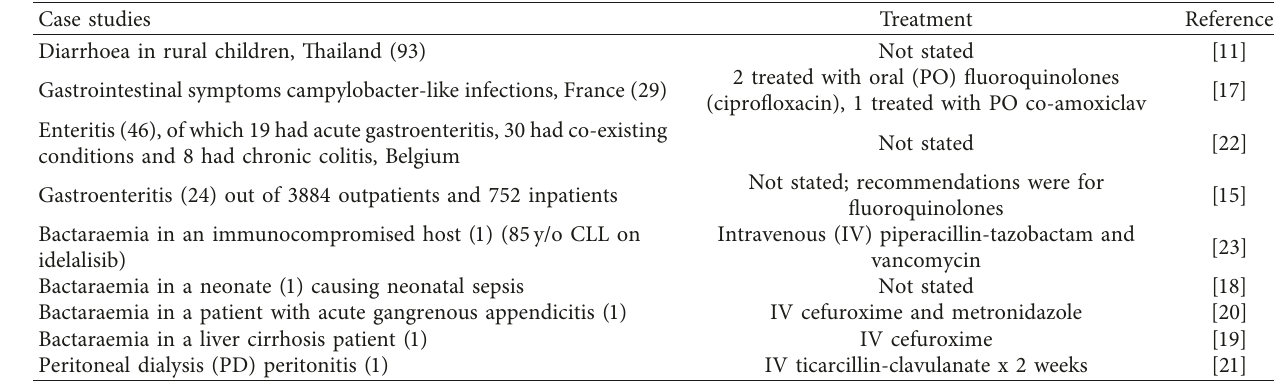
Table 1: Case series of documented A. butzleri